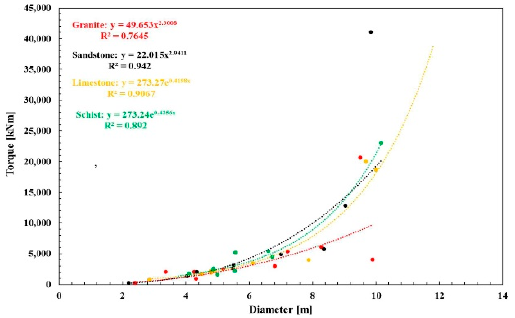
Figure 18. Correlation between the diameter and the torque due to the excavation in granite, sand ‐ stone, limestone, and schist by double shield TBMs.